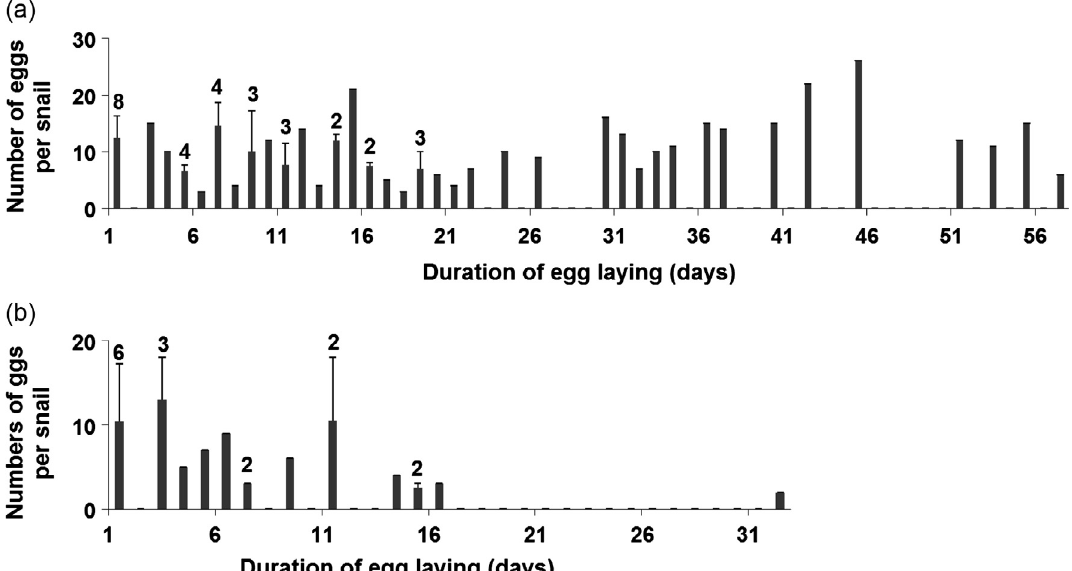
Figure 2. Numerical distribution of eggs per Radix natalensis and per day of the egg-laying period in the non-cercarial-shedding (a) and cercarial-shedding (b) snails of the exposed group. The figure on the top of each bar indicates the number of snails which laid eggs during this day (absence of figure: 1 snail